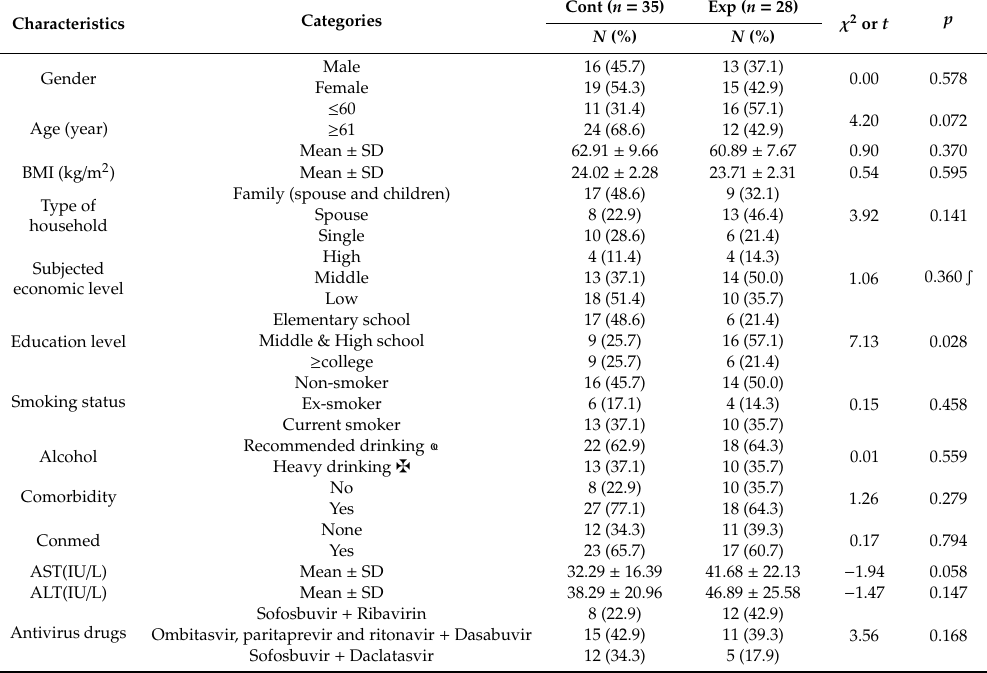
Table 2. Homogeneity test for general characteristics and disease-related characteristics of participants in experimental and control Groups ( N = 63).